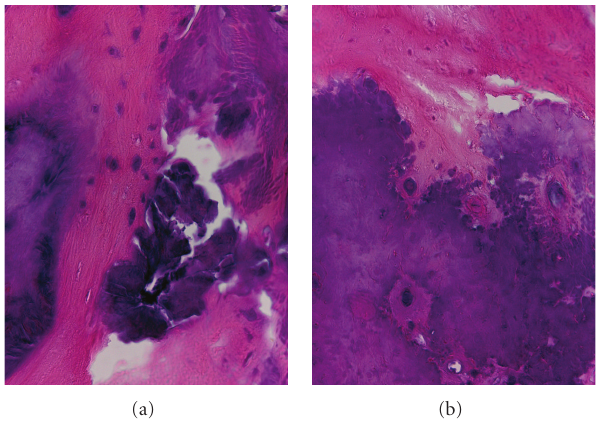
Figure 7: Histological signs of remodelling. Hematoxyline-Eosine stained sections. (Magnification: 40x). (a) shows the injected pCPC in contact with newly formed bone. (b) shows an implanted bone chip. Newly formed bone is seen in contact with the slowly remodelling calcified bone